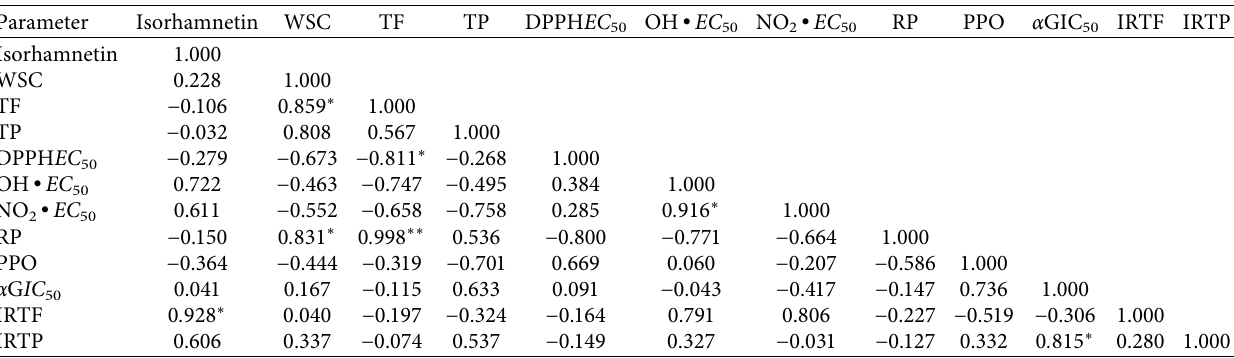
Table 3: Correlation coefcients for the relationship of isorhamnetin, water-soluble carbohydrate (WSC), total favonoids (TF), total soluble polyphenols (TP), DPPH scavenging activity (DPPH EC 50 ), hydroxyl radical scavenging ability (OH ∙ EC 50 ), nitrite scavenging ability (NO 2 ∙ EC 50 ), reducing power (RP), polyphenol oxidase activity (PPO), α -glucosidase inhibitory activity( α G IC 50 ), and lipase inhibitory activity (IRTF and IRTP) of sea buckthorn leaf